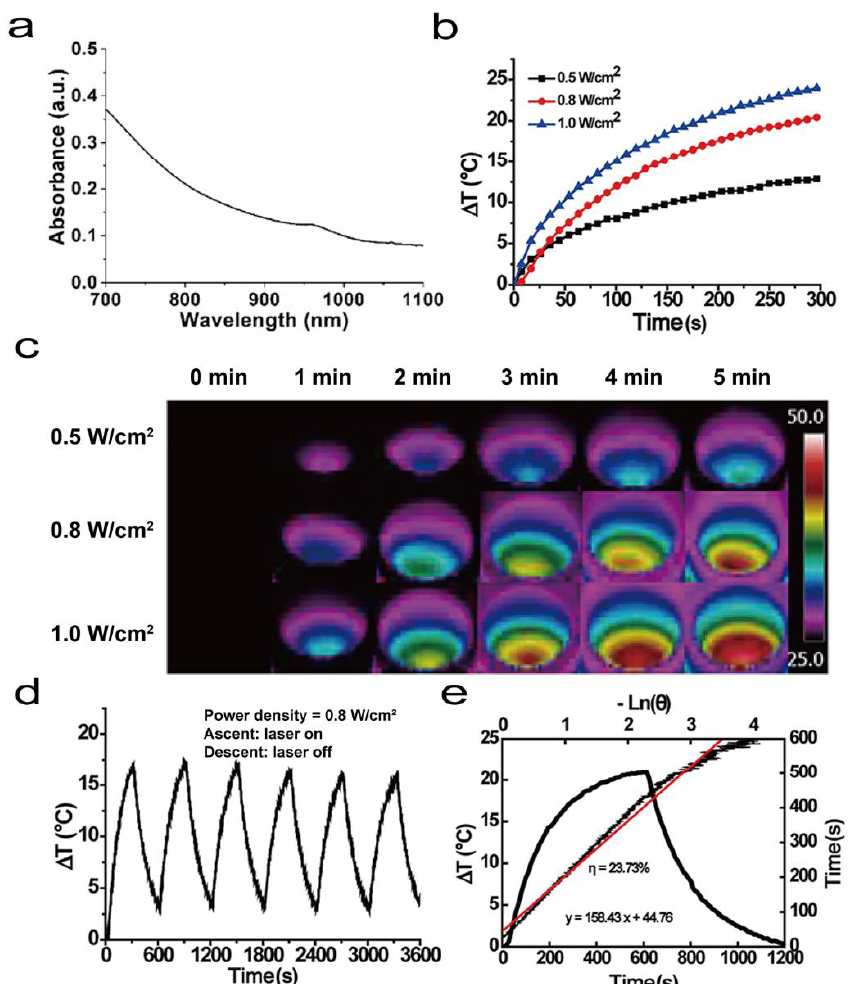
Figure 4. Photothermal conversion capacity of COL hydrogel. ( a ) NIR region of the UV – vis – NIR spectrum recorded for chitosan/polyaniline/laponite (COL) hydrogel. ( b ) Temperature rise curve of COL hydrogel containing saline at different laser densities of 808 nm for 5 min. ( c ) Thermogram of COL hydrogel corresponding to ( a ). ( d ) Photothermal stability of COL hydrogel over 6 lasers ’ on/off cycles. ( e ) Temperature rise and fall curves and η of COL hydrogel.